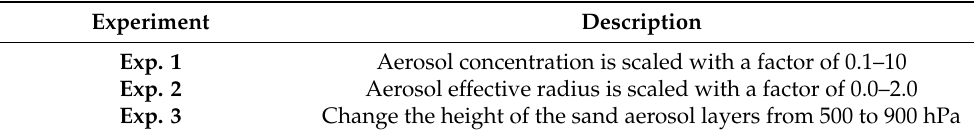
Table 2. The descriptions of the three sensitivity experiments. Experiment